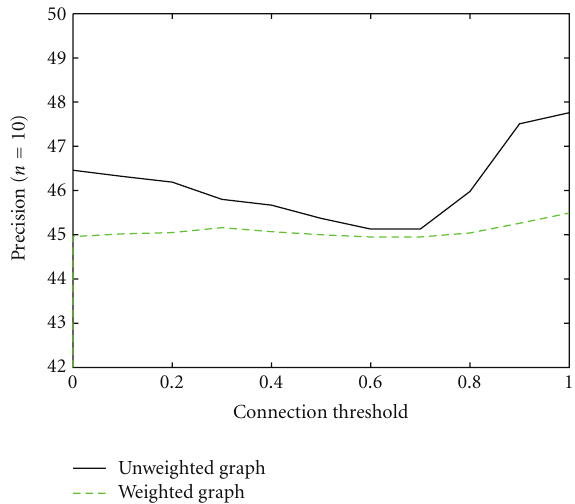
Figure 6: Precision values on MovieLens according to the connec- tivity threshold θ .